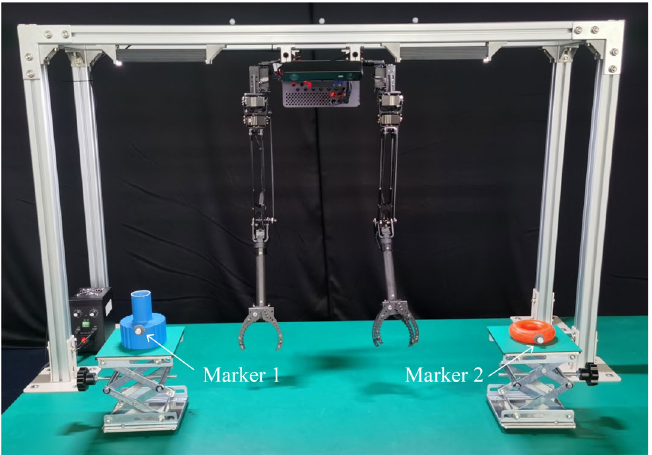
Figure 13. Test of cooperative bimanual manipulation.